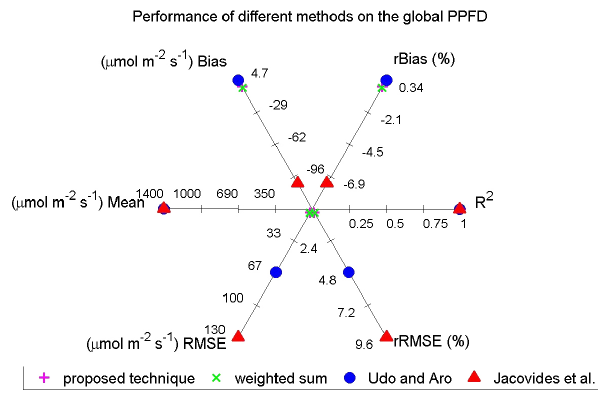
Figure 2. Performance of different methods: Jacovides et al. (2004); Udo and Aro (1999), weighted sum and the proposed